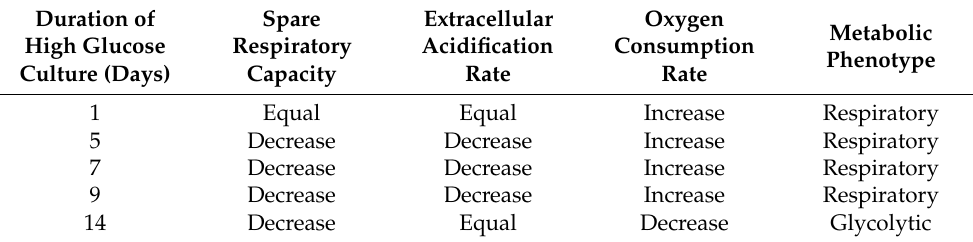
Table 2. A summary of the metabolic changes from hyperglycemia compared to the